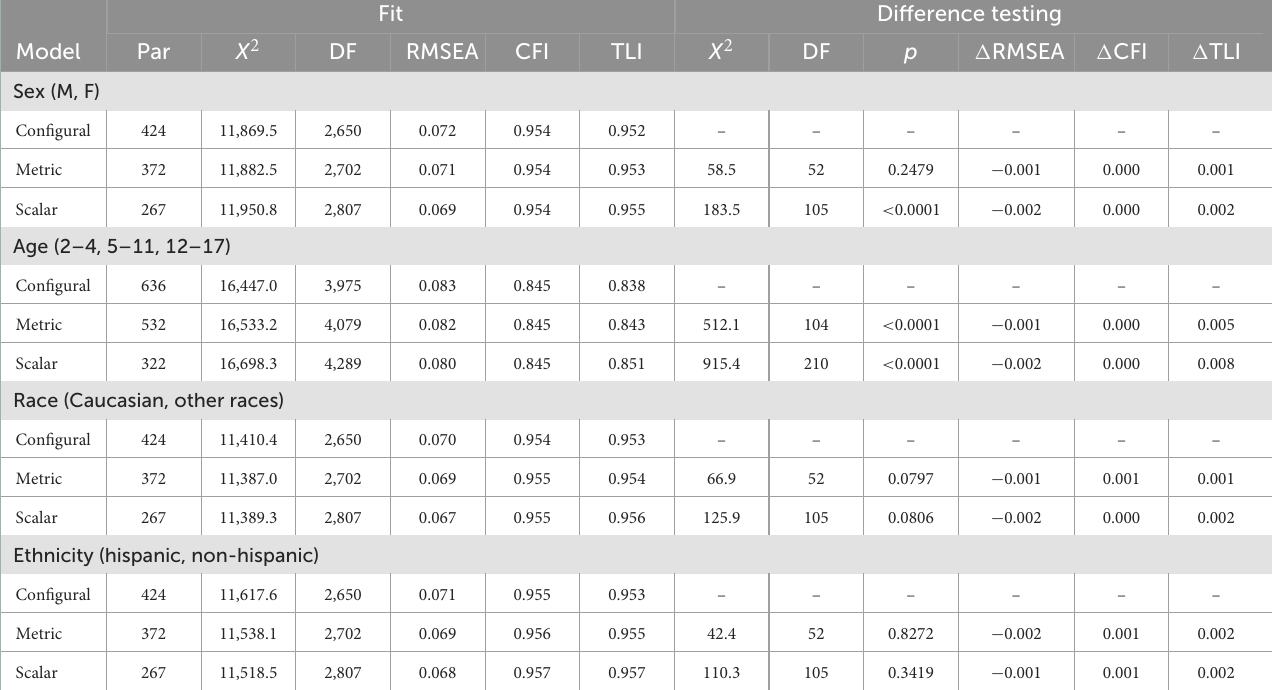
TABLE 2 Measurement invariance analyses for the final DLS factor model across sex, age, race, and ethnicity. Fit